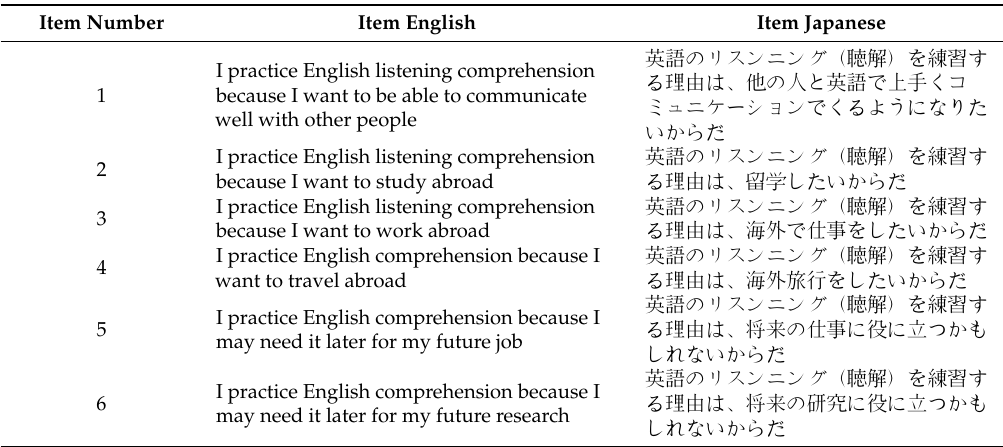
Table A1. Instrumental Motivation.